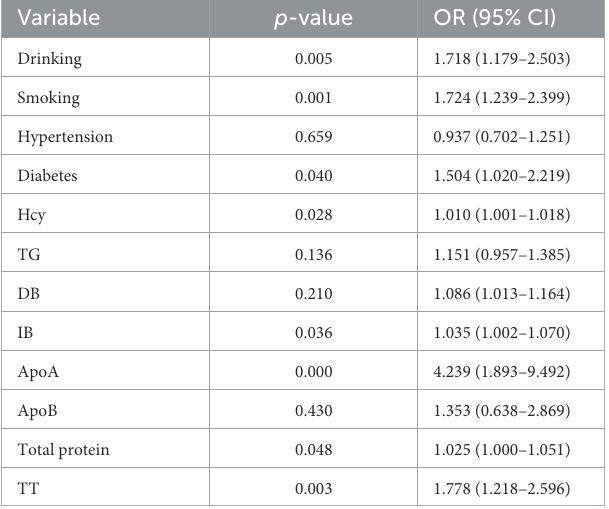
TABLE 7 Logistic regression analysis of risk of CI in the population of Northwest China.